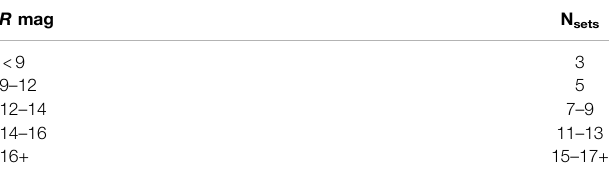
TABLE 1 | Number of 1,000 frame sets as a function of target